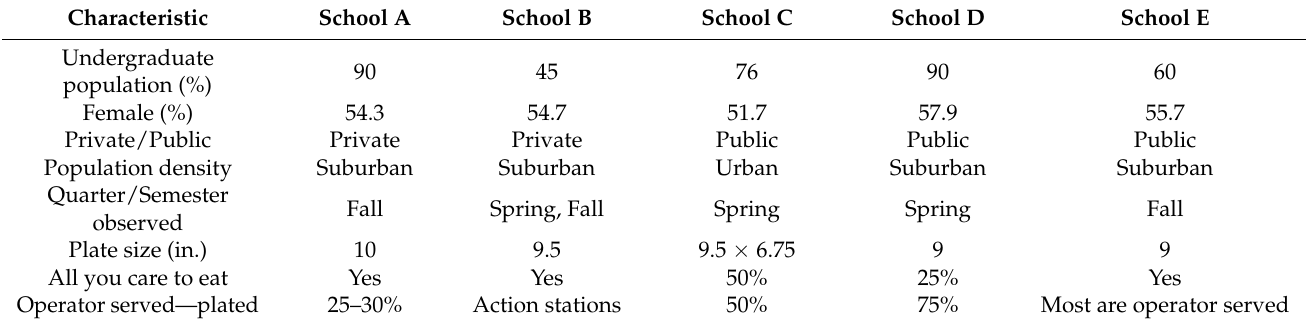
Table 1. Characteristics of the schools which participated in this